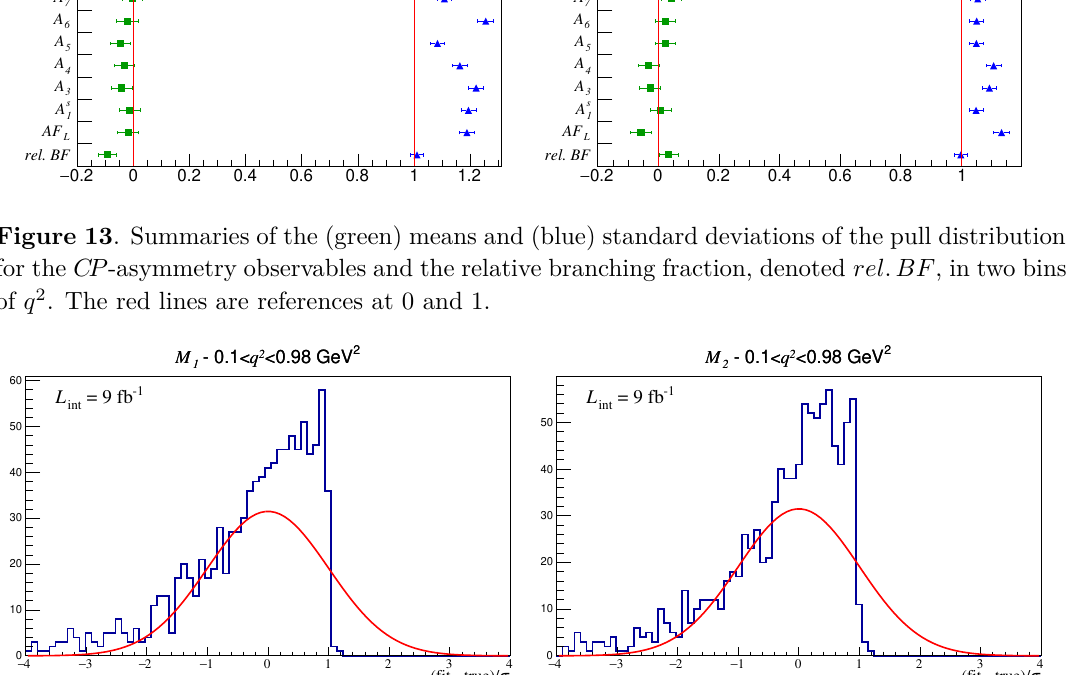
Figure 14 . The pull distributions for the optimised P-wave observables (left) M 1 and (right) M 2 from pseudoexperiments with the estimated LHCb Run 2 yields. The overlaid red curve is a reference of the ideal distribution for the pulls, a Gaussian function with σ = 1